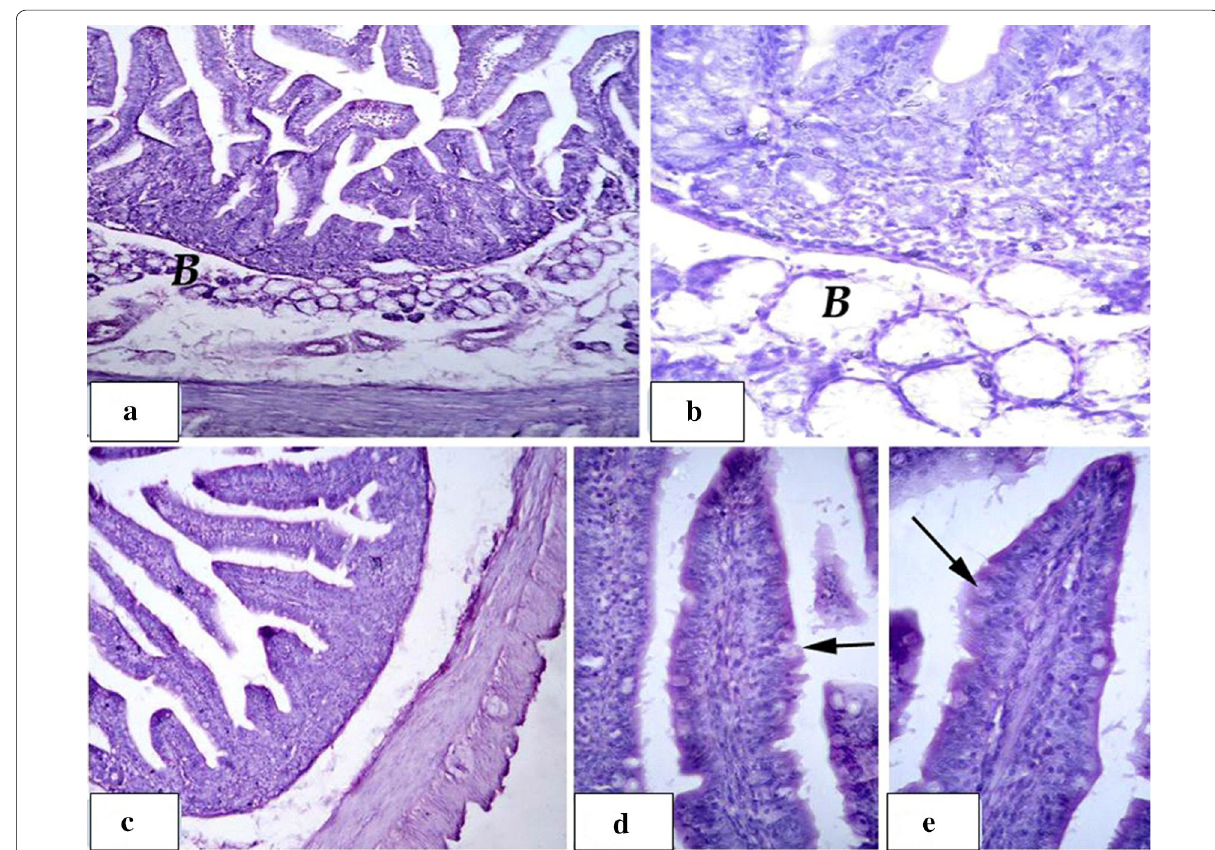
Fig. 1 Group T3: a , b showing normal duodenum mucosa and submucosa with brunners gland (B). c – e Normal jejunum mucosa and submucosa with normal covering epithelium of columnar absorptive and goblet cells